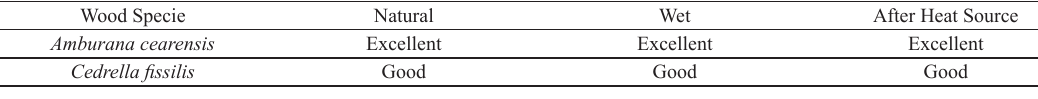
Table 2. Smell on Different conditions.